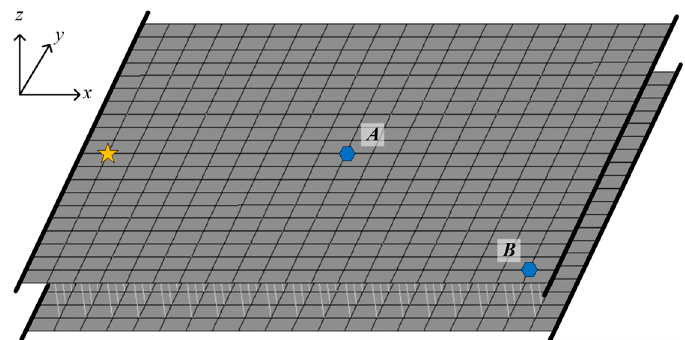
Figure 3. The metamaterial sandwich plate with two opposite clamped edges.